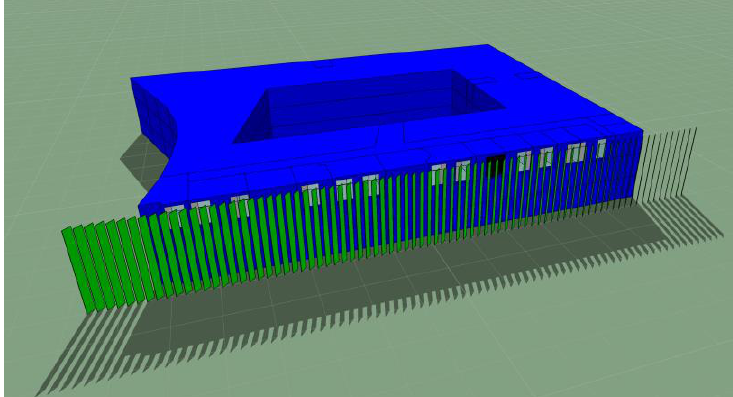
Figure 9. IESVE model of the building.